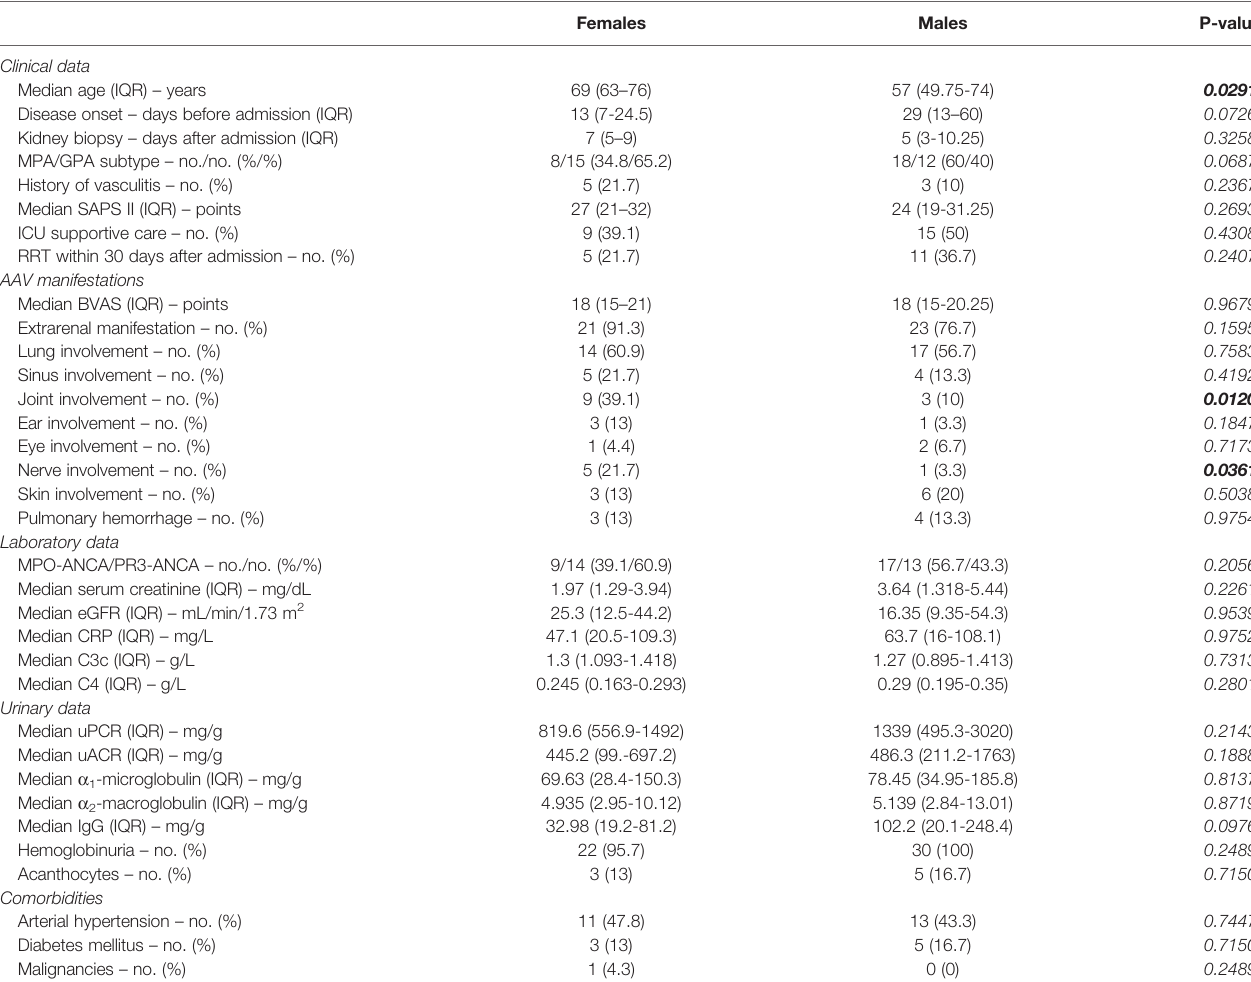
TABLE 2 | Sex differences among clinical and laboratory parameters at disease onset in ANCA